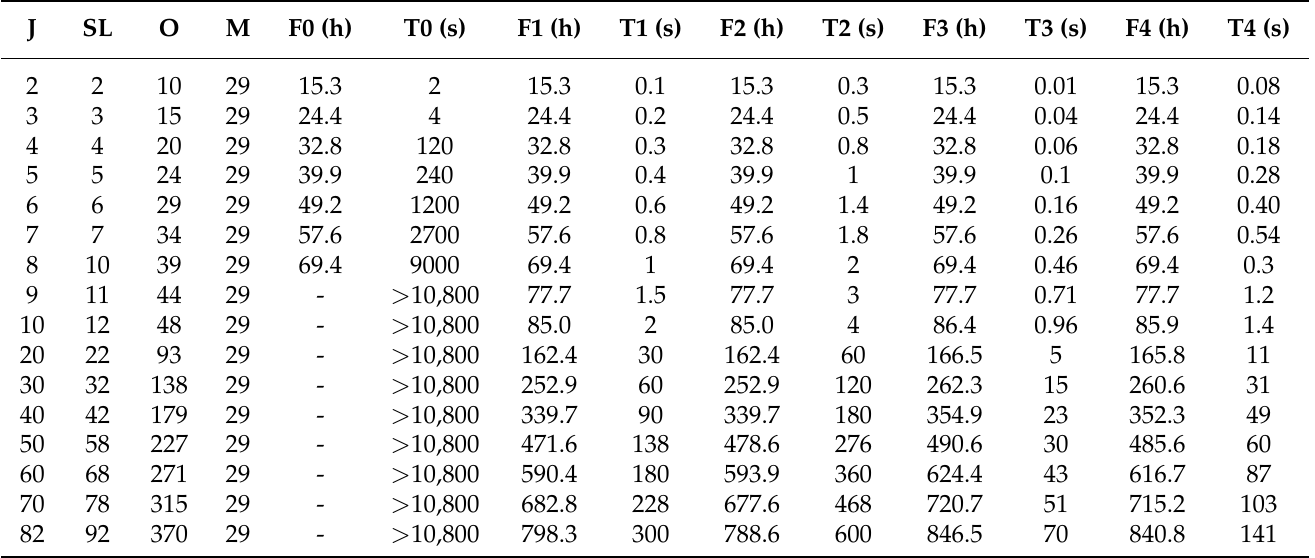
Table 5. Computational results of the developed resolution methods for real instances of the hospital center of Troyes (HCT). J